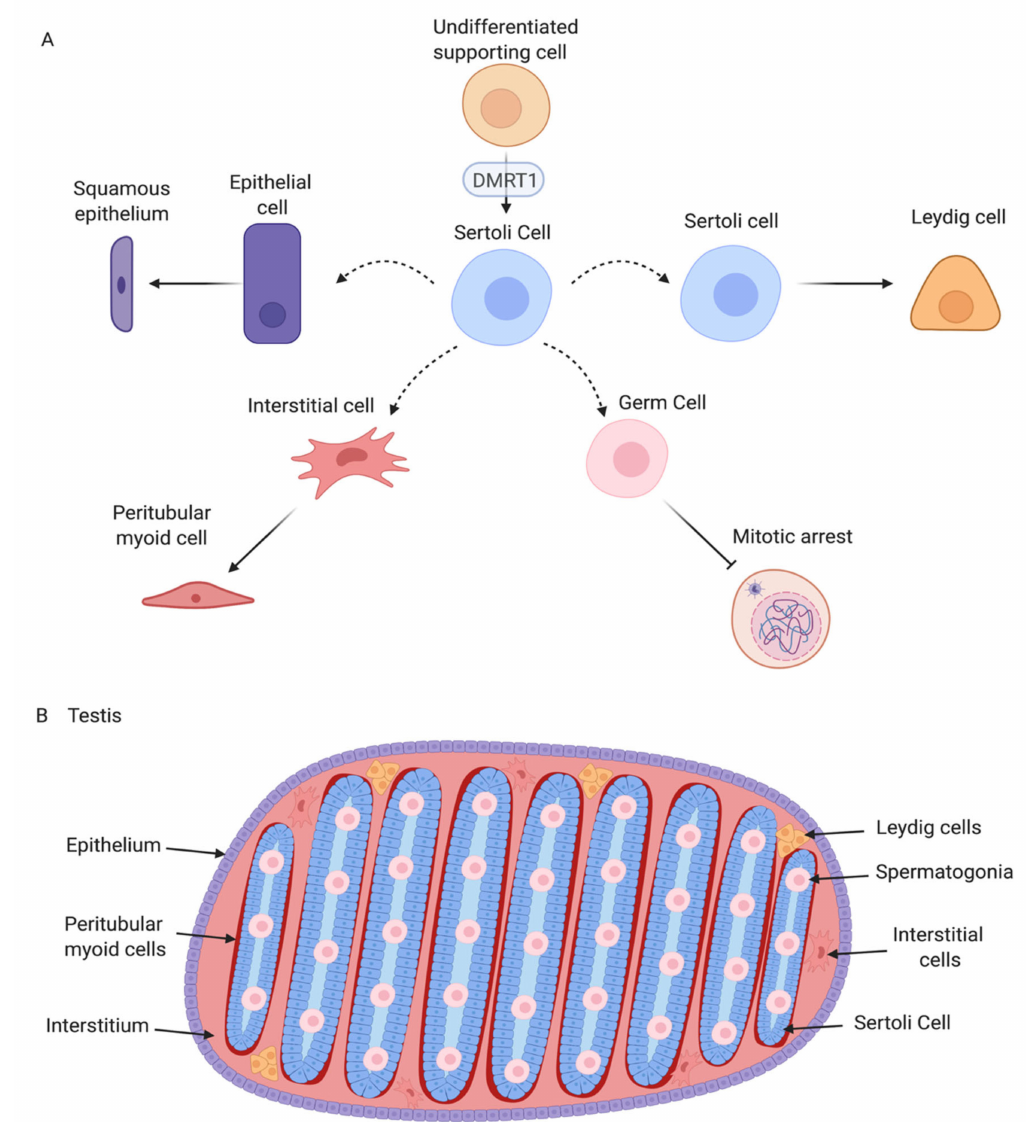
Figure 7. Testicular differentiation in the chicken embryo. ( A ) The first cells to differentiate are the Sertoli cells. They then regulate differentiation of other cell types in the testis. Epithelial cells become squamous, interstitial cells differentiate into peritubular myoid cells and upregulate ACTA2 . Germ cells do not enter meiosis and are arrested in in G1/G0. Some Sertoli cells differentiate into steroidogenic Leydig cells. ( B ) The testis has a clear organised structure of seminiferous tubules, containing Sertoli cells and germ cells. Myoid cells are present surrounding those tubules. Leydig cells, and interstitial cells are located in the space between the tubules. Image created with